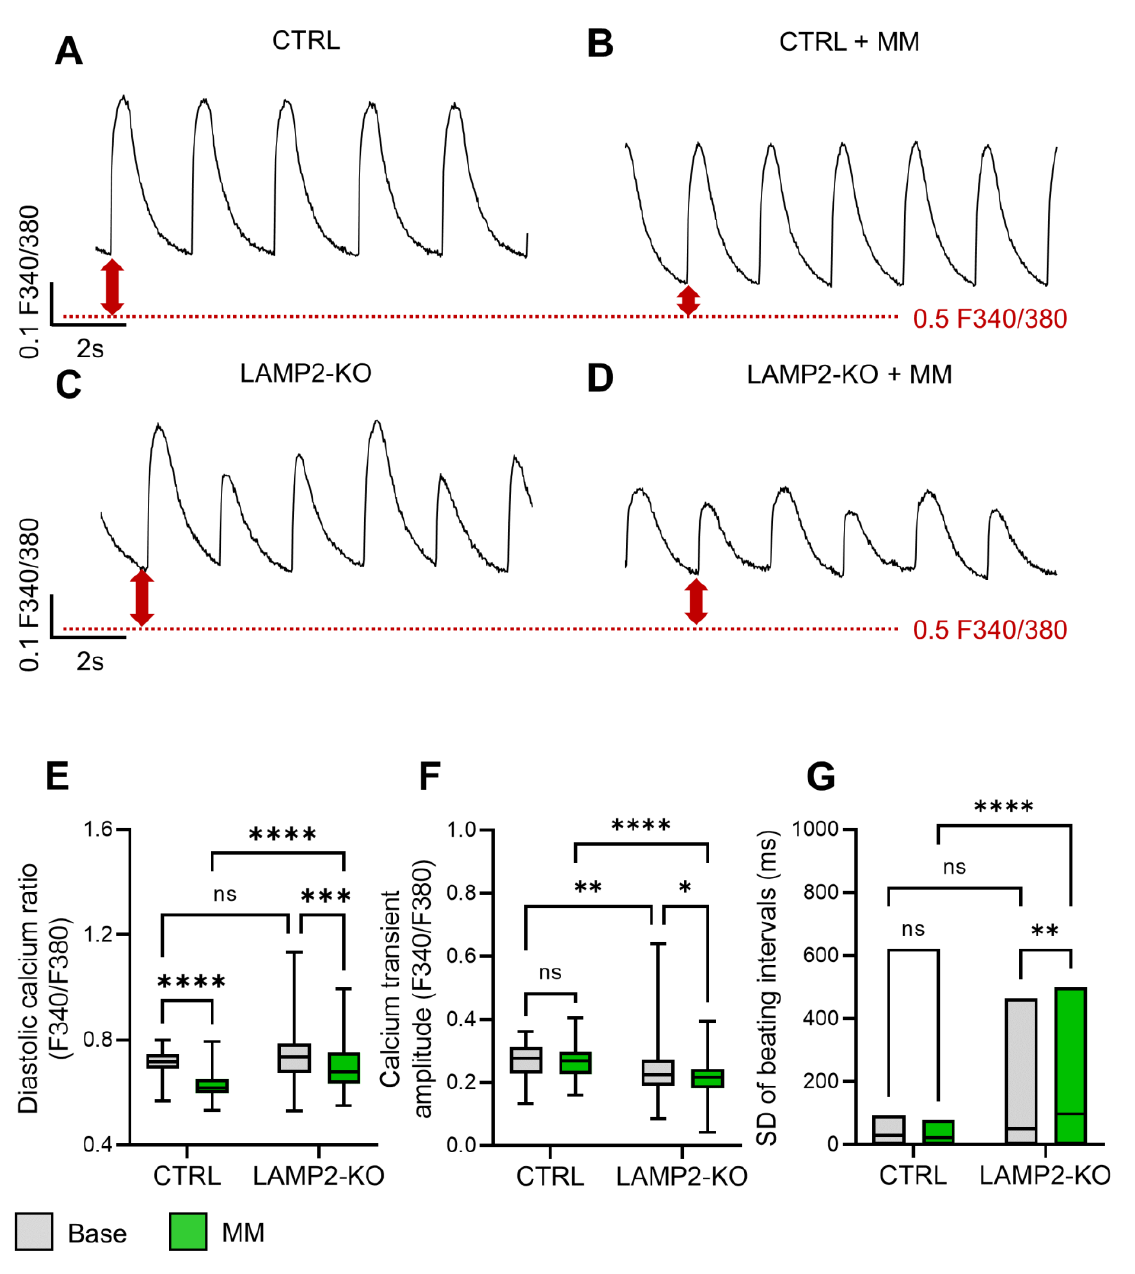
Figure 4. Metabolic maturation enhanced pro-arrhythmic calcium signaling in LAMP2 KO iPSC- CMs. ( A,B ) Representative Fura-2 calcium transient trace in Ctrl iPSC-CMs before ( A ) and after ( B ) maturation medium (MM) treatment for 48 h; ( C,D ) Representative Fura-2 calcium transient trace in LAMP2 KO iPSC-CMs before ( C ) and after ( D ) maturation medium (MM) treatment for 48 h. Cell were paced at 0.5 HZ in all the groups; ( E – G ) LAMP2 KO iPSC-CMs showed unchanged diastolic cytosol calcium level ( E ), slightly decreased calcium transient amplitude ( F ), and a trend of increased irregular beating ( G ) compared to Ctrl group. MM treatment significantly brought down the diastolic calcium levels in both Ctrl and LAMP2 KO iPSC-CMs, yet only induced decreased transient amplitude and increased irregular beating events in the LAMP2 KO group. N = 80, 91, 88, and 114 cells in Ctrl, LAMP2 KO, Ctrl + MM, and LAMP2 KO + MM group from at least 3 independent experiments. ns: no significance, * p < 0.05, ** p < 0.01, *** p < 0.001, and **** p < 0.0001 by two-way ANOVA followed by test Holm – Sidak method.